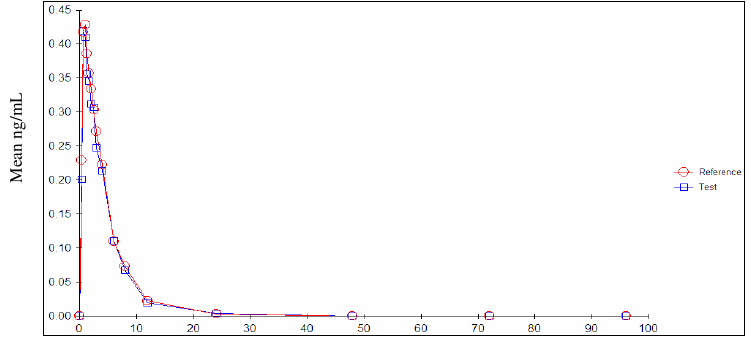
Figure 8. . Representative chromatograms of subject sample for MHA spiked with IS